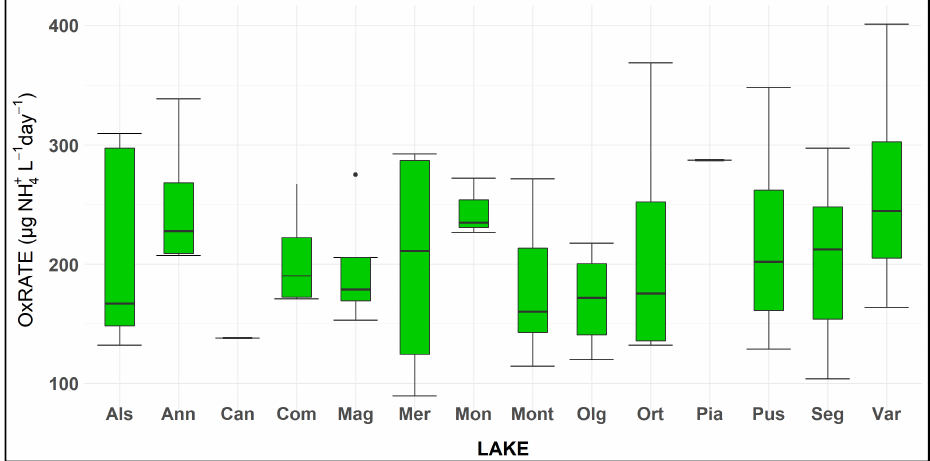
the study. Box plot statistics: the lower and upper hinges correspond to the first and third quartiles. The upper (lower) whisker extends from the hinge to the largest (smallest) value no further than 1.5 × InterQuartileRange from the hinge. Data beyond the end of the whiskers are outlying points and are plotted individually.